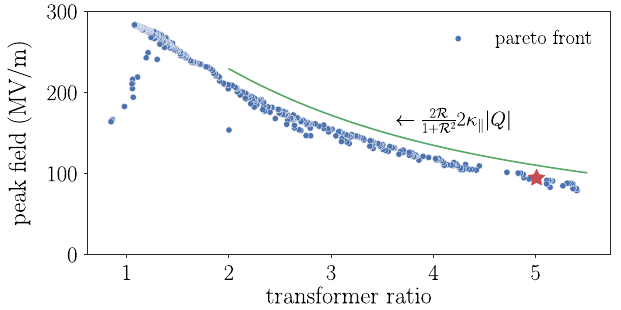
FIG. 15. Comparison of the Pareto front with the analytical trade-off curve between the peak field and transformer ratio described by Eq. (30) of Ref. [10]. Each blue dot represents a numerically simulated configuration with the red star represent- ing the configuration with parameters listed in Table IV.